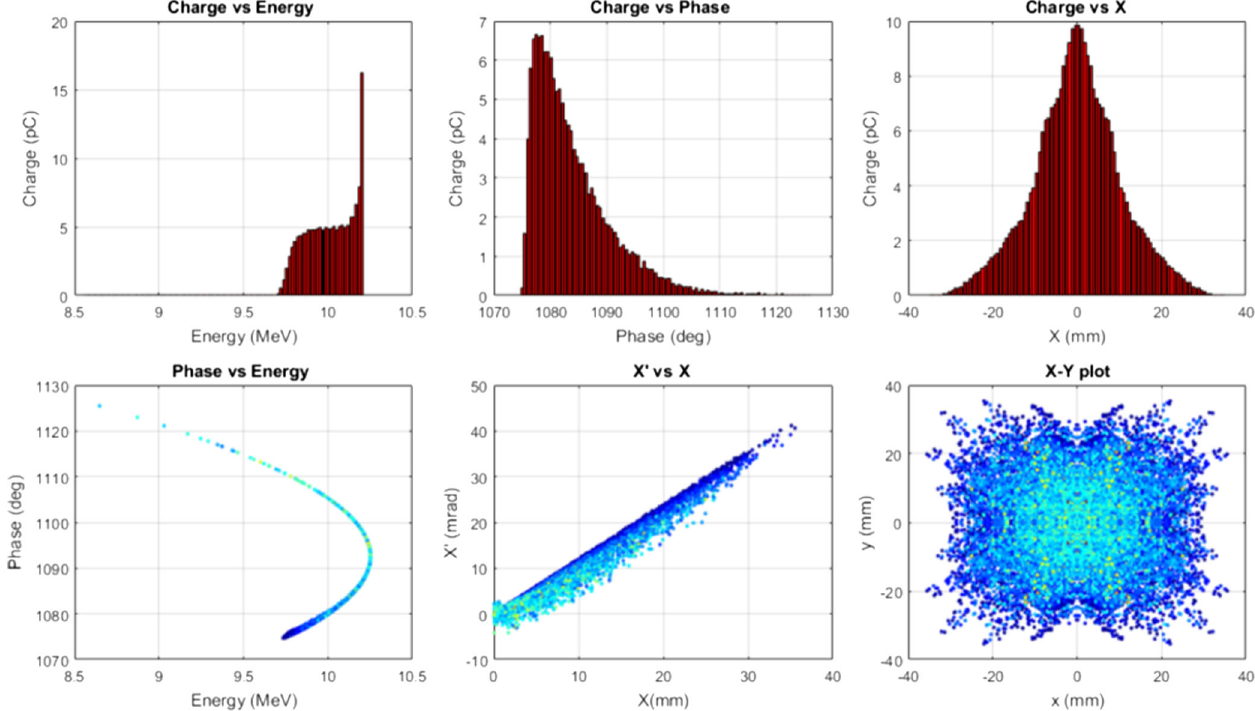
FIG. 12. Beam characteristics and particle distributions at the exit of the five-cell cavity. Top plots: charge distribution vs energy and phase and current vs radius; bottom plots: phase vs energy, x 0 − x phase-space distribution, and x − y beam spot size.